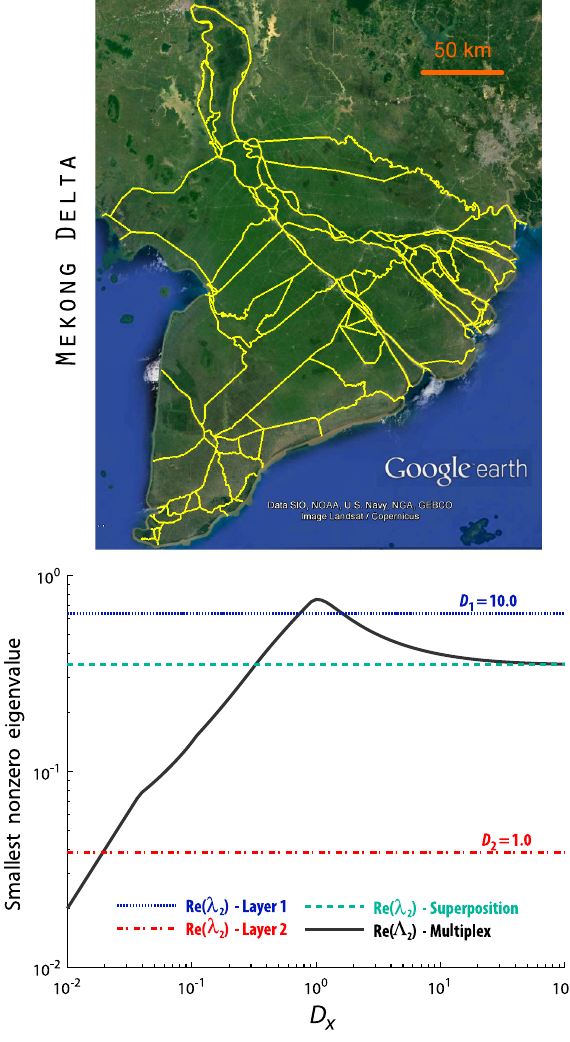
FIG. 2. (a) The panel depicts (from top left to bottom right) eight networks with the same number of nodes ( N ¼ 100 ) and decreas- ing value of the NDI as shown on top of each network (details on the construction of these networks are given in Appendix F). (b) The panel shows the prime regime index( P ) as a function of the NDI indicating that in this scenario the prime regime ( P > 0 ) emerges only for topologies characterized with NDI ⪆ 0 . 3 .